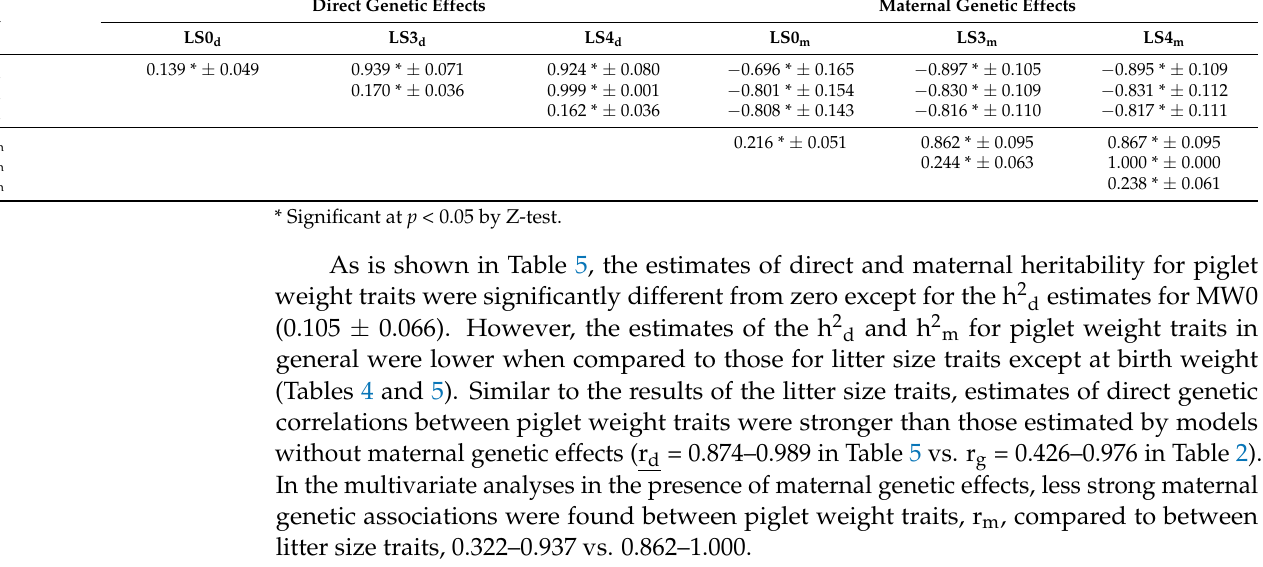
Table 5. Direct and maternal heritability estimates (diagonals), genetic correlations (upper diagonals), and SE (lower diagonals) of piglet weight before weaning from a three-trait animal model with maternal genetic